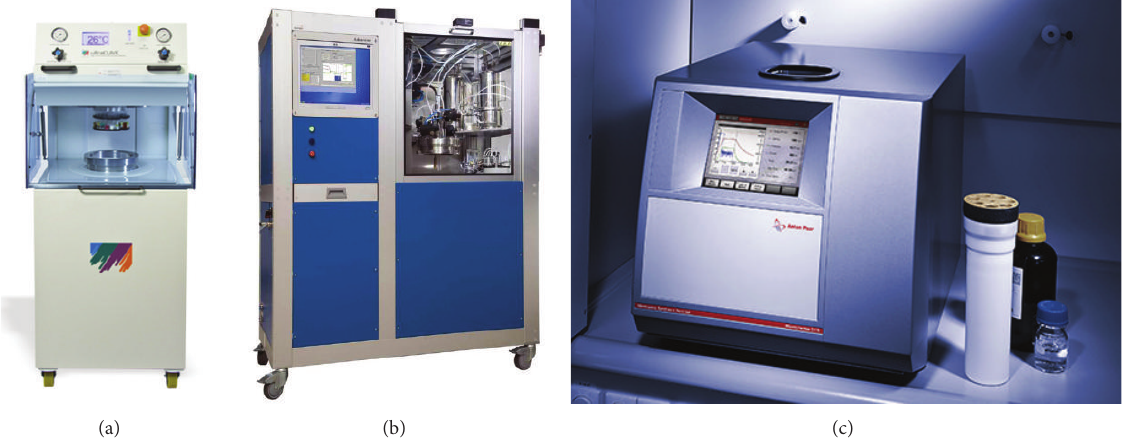
Figure 4: UltraClave (Milestone/MLS), Advancer (Biotage), and Masterwave BTR (Anton Paar).